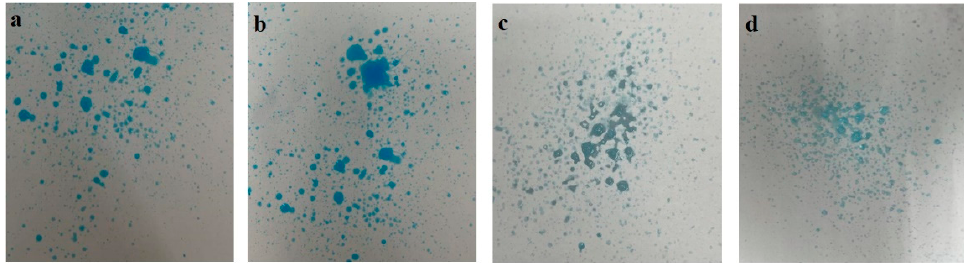
Figure 2. Spray patterns of the formulation ( a ) F, ( b ) F1, ( c ) F2, and ( d ) F3.